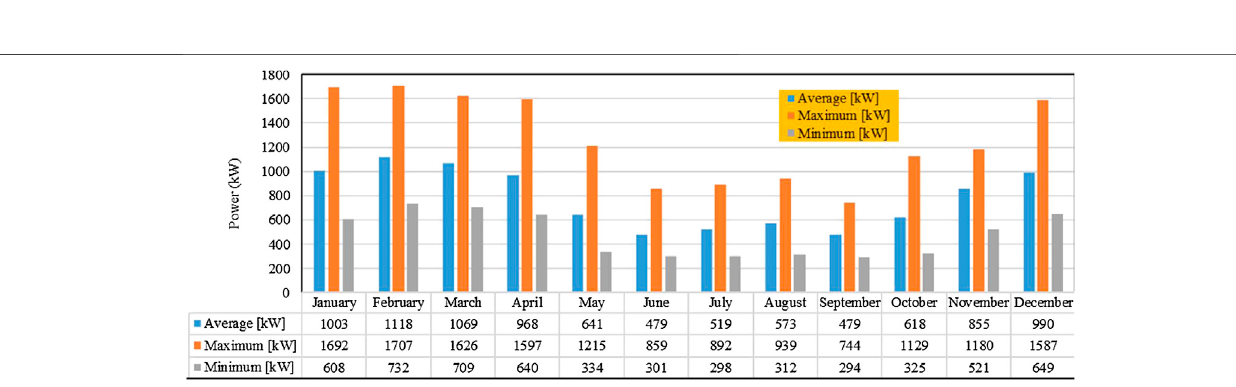
Frontiers in Energy Research |